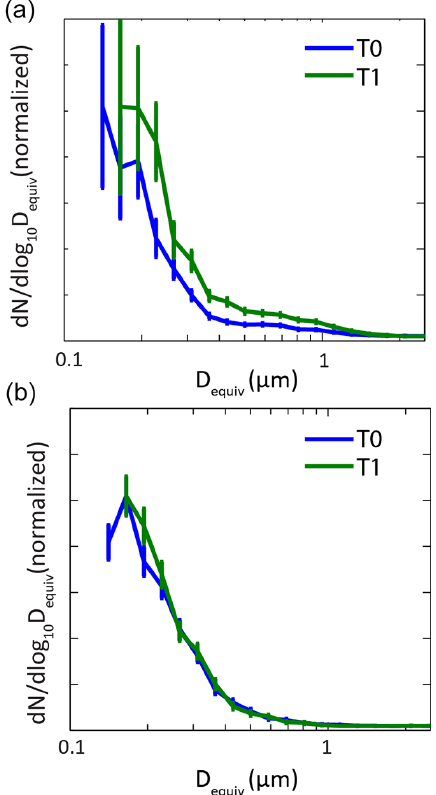
Figure 4. (a) Size distribution of BC containing particles at T0 (blue) and T1 (green). (b) Size distribution of BC inclusions at T0 (blue) and T1 (green).